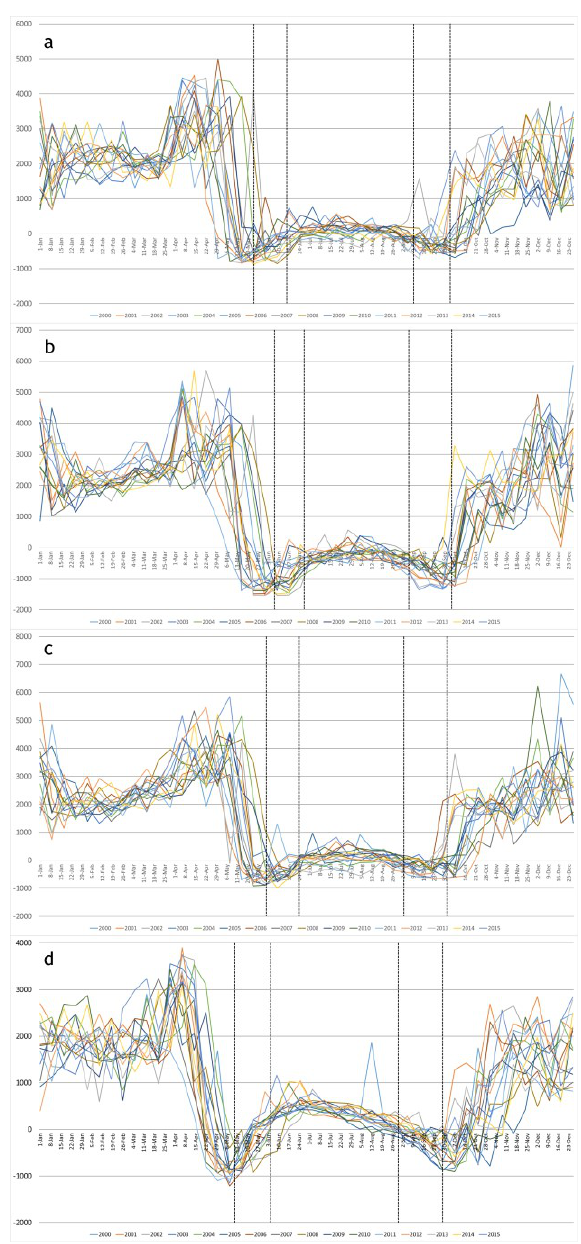
Figure 1. Annual graphs of NDWI produced form MODIS imagery for the years 2000-2015 for the Irael (a), Nar’yan-Mar (b), Petrun’ (c) and Syktyvkar (d) weather stations (data are averaged in the 10 by 10 kilometers area around the stations); index values are scaled by 10000 coefficient; black vertical lines show average dates of the growing season frames accordingly to the data of ground observations at the corresponding weather stations